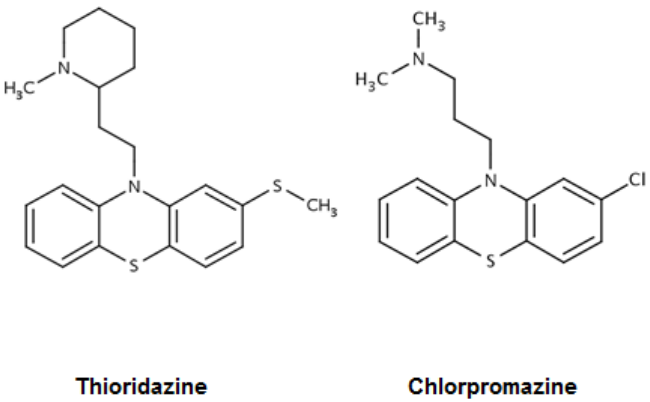
Figure 1. Structures of the phenothiazines thioridazine and chlorpromazine [9].